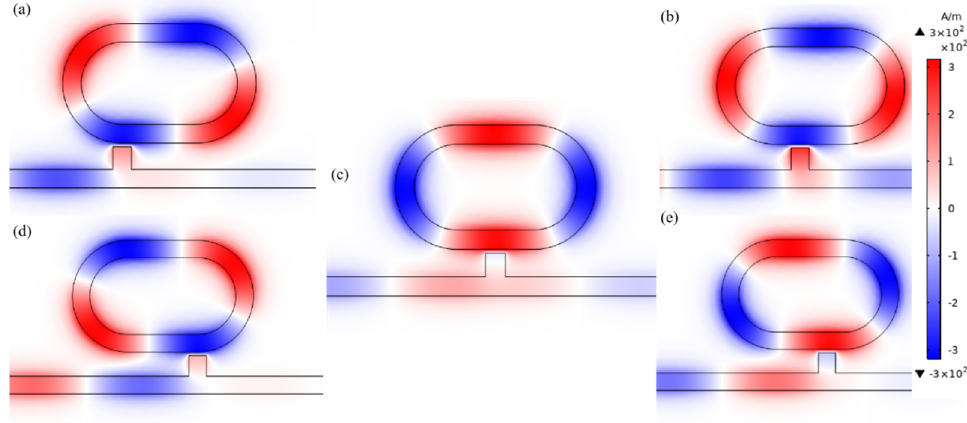
Figure 5. The magnetic field distribution H Z at the Fano resonance dip λ = 1815 nm of ( a ) x = 0 nm; ( b ) x = 50nm; ( c ) x = 100 nm; ( d ) x = 150 nm; ( e ) x = 200 nm.